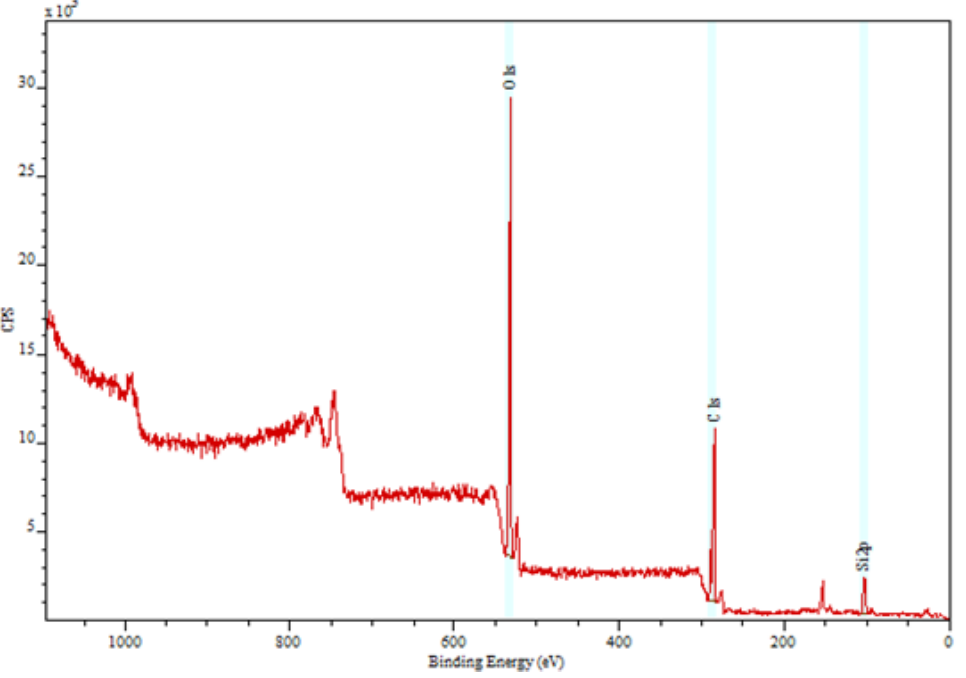
Figure 7. XPS spectrum of the combination of Gantrez TM AN-119 BF and amphotericin B.